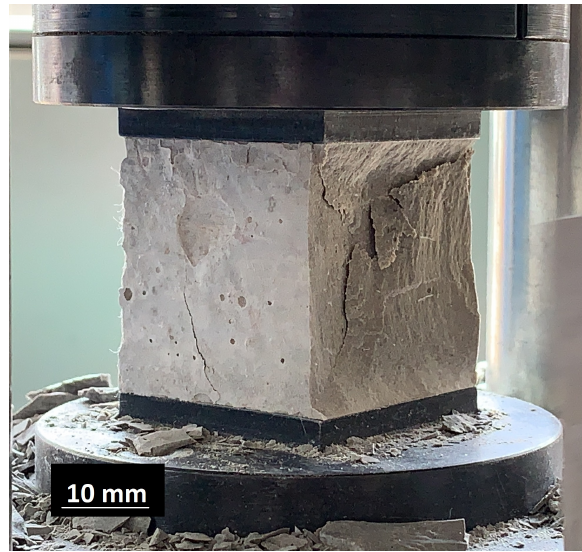
Figure 7. Test of cement paste cube for compressive strength.